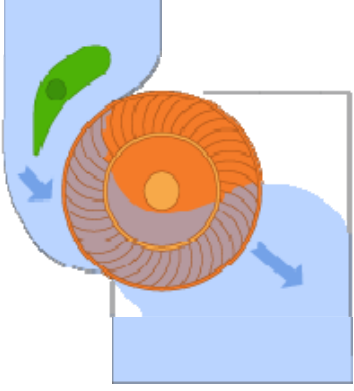
Figure 10. Cross-flow turbine.